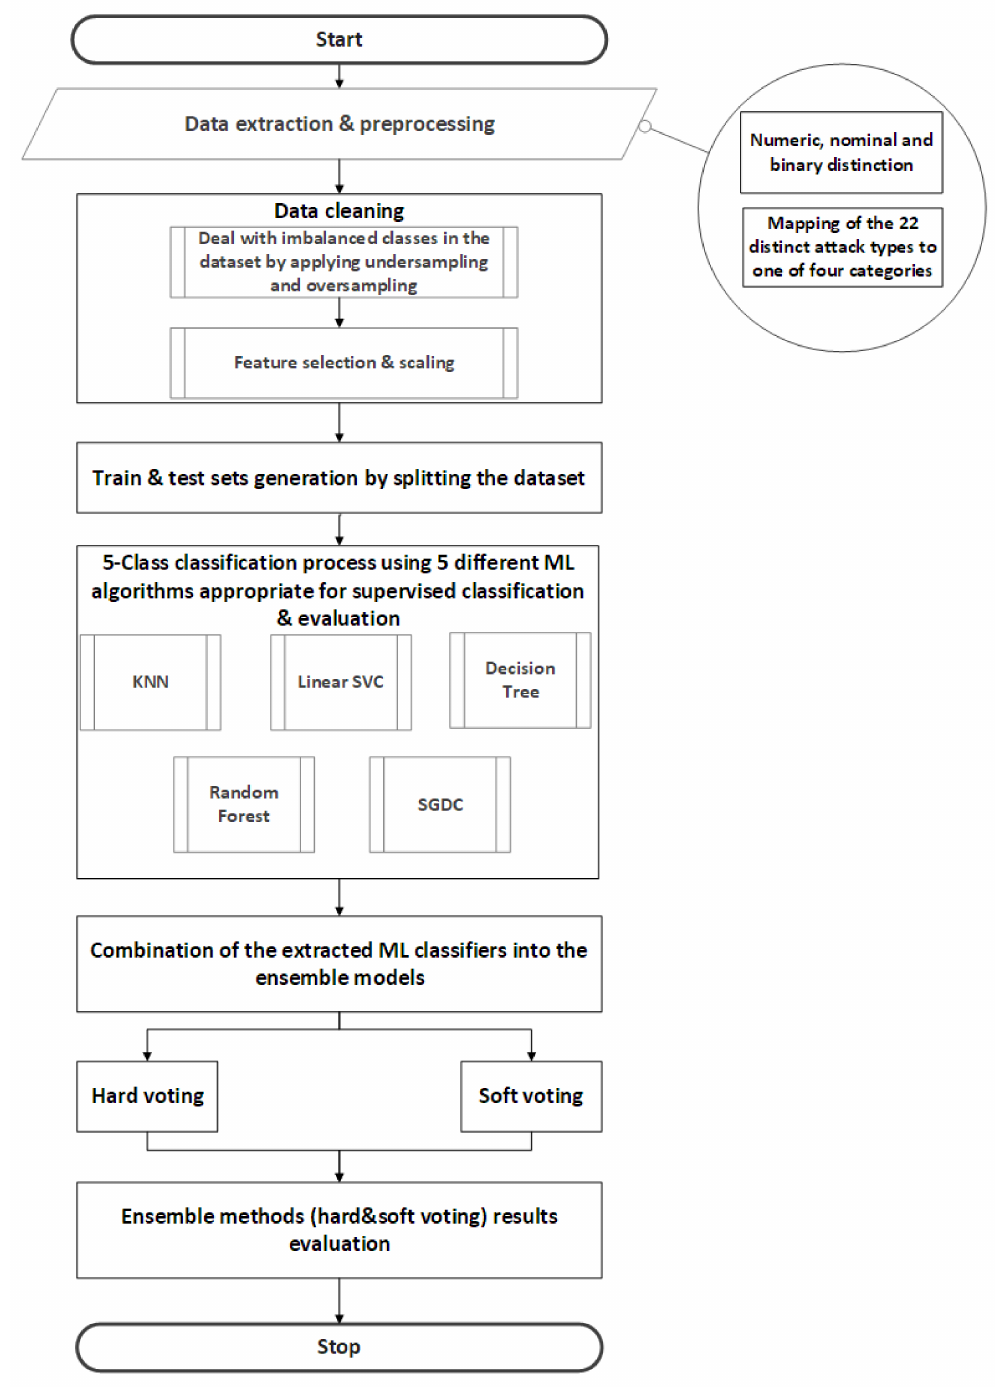
Figure 5. Methodology steps taken for this